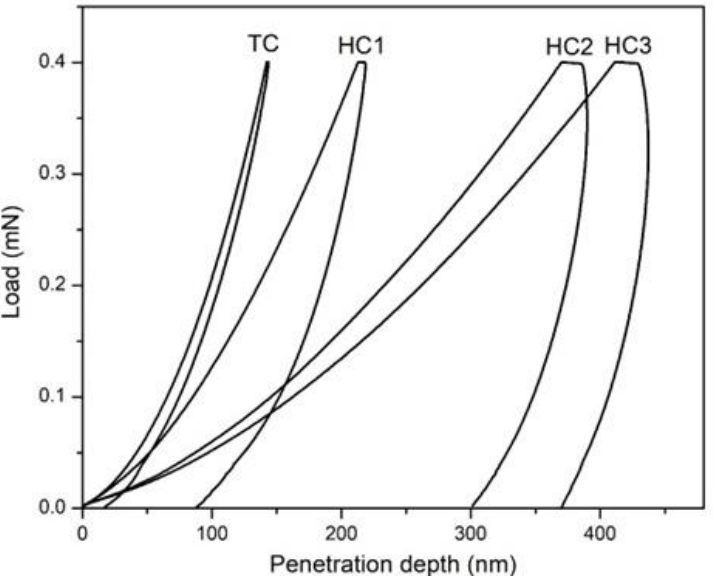
Figure 5. Loading–unloading cycles for hybrid coatings with 0:1:0 (TC), 1:2:0.5 (HC1), 1:1:0.5 (HC2), and 1:0:0.5 (HC3) molar ratios of R-UPR:TEOS:TMSPM.